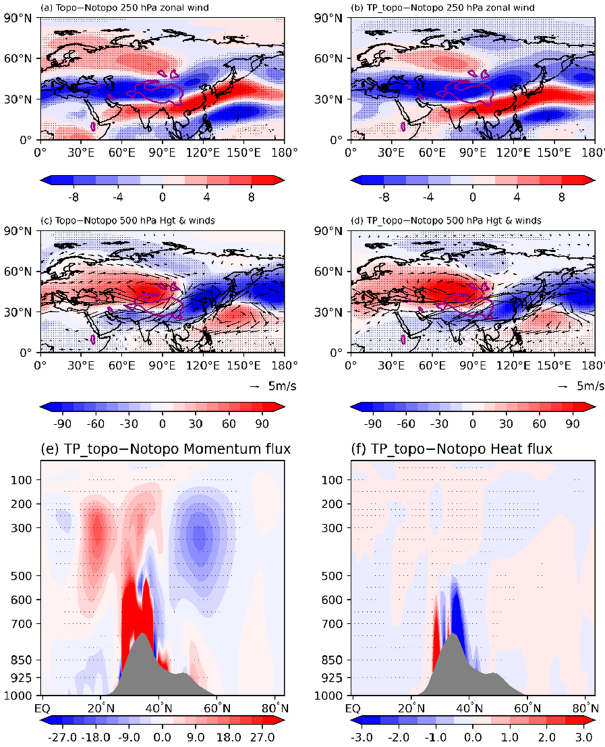
Figure 5. The differences in 250 hPa zonal wind (unit: m/s); zonal deviation of 500 hPa geopotential height (shaded unit: gpm) and winds (vector, unit: m/s); and pressure − latitude cross-section of eddy momentum flux (unit: (m/s) 2 ) and eddy heat flux (unit: m·k/s) averaged from 60.46° E − 90° E between the Topo and Notopo tests ( a , c , e ), and Tp_topo and Notopo tests ( b , d , f ). Dots denote values and black vectors exceeding the 95% confidence level of Student’s t test. The purple line is the 2000 m elevation contour.